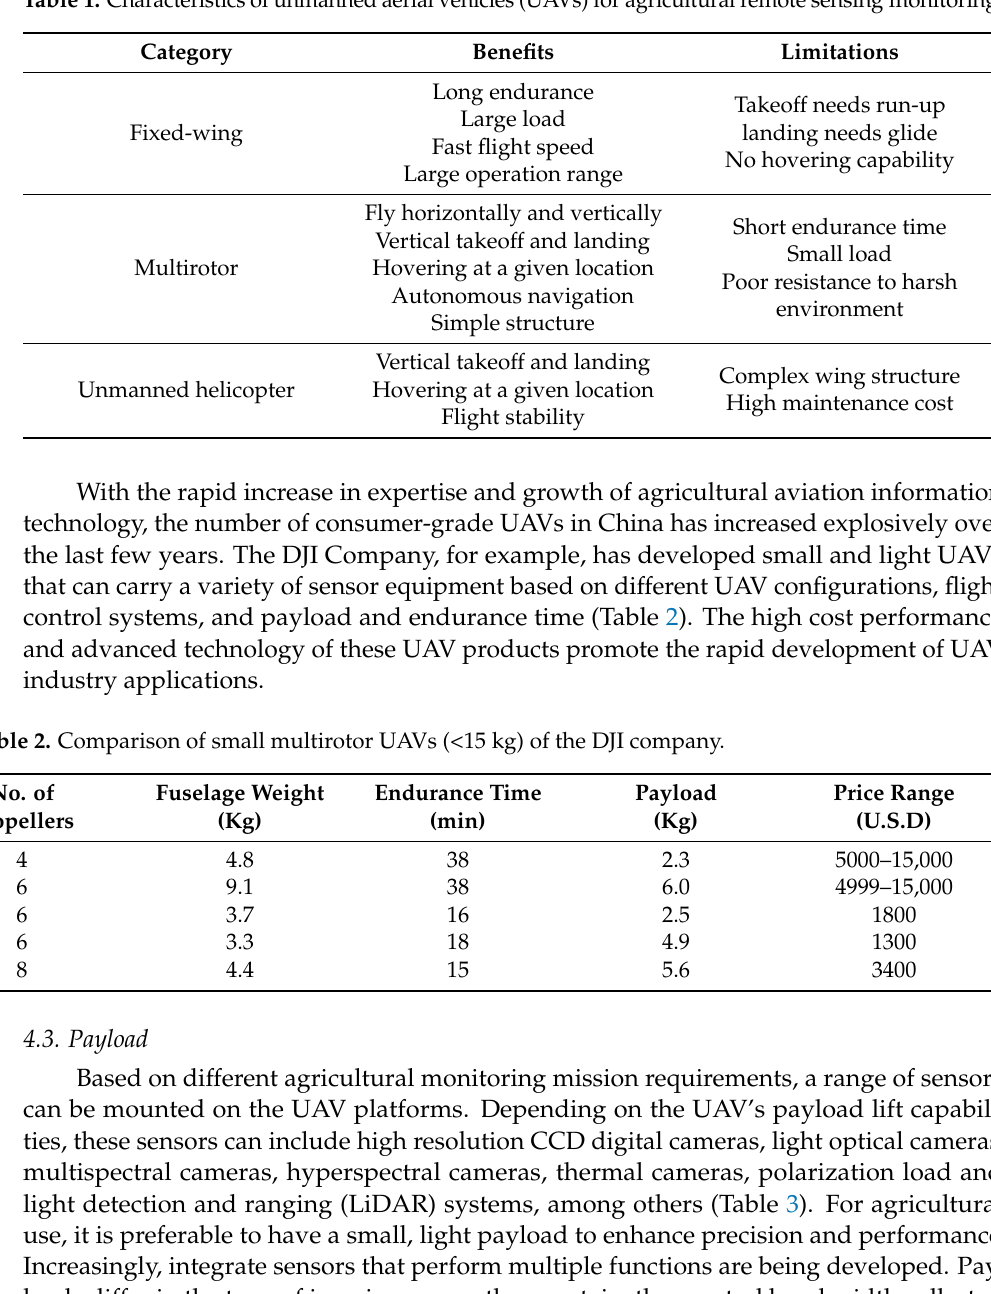
Table 1. Characteristics of unmanned aerial vehicles (UAVs) for agricultural remote sensing monitoring. Category